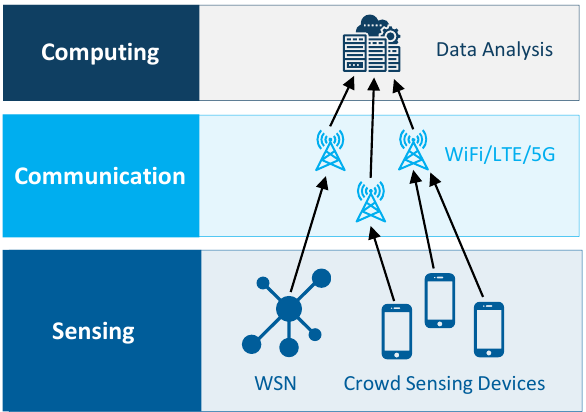
Figure 2. An example of smart city monitoring.